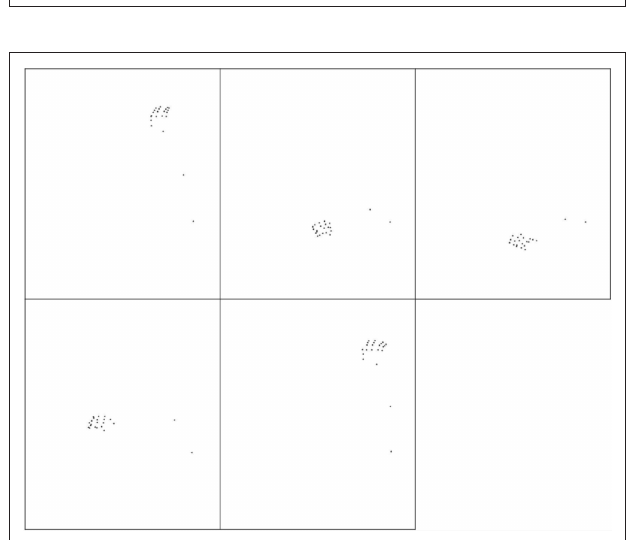
Figure 2 | Five frames (black-on-white for clarity) at 4 s intervals from the drink from mug sequence, right side up.